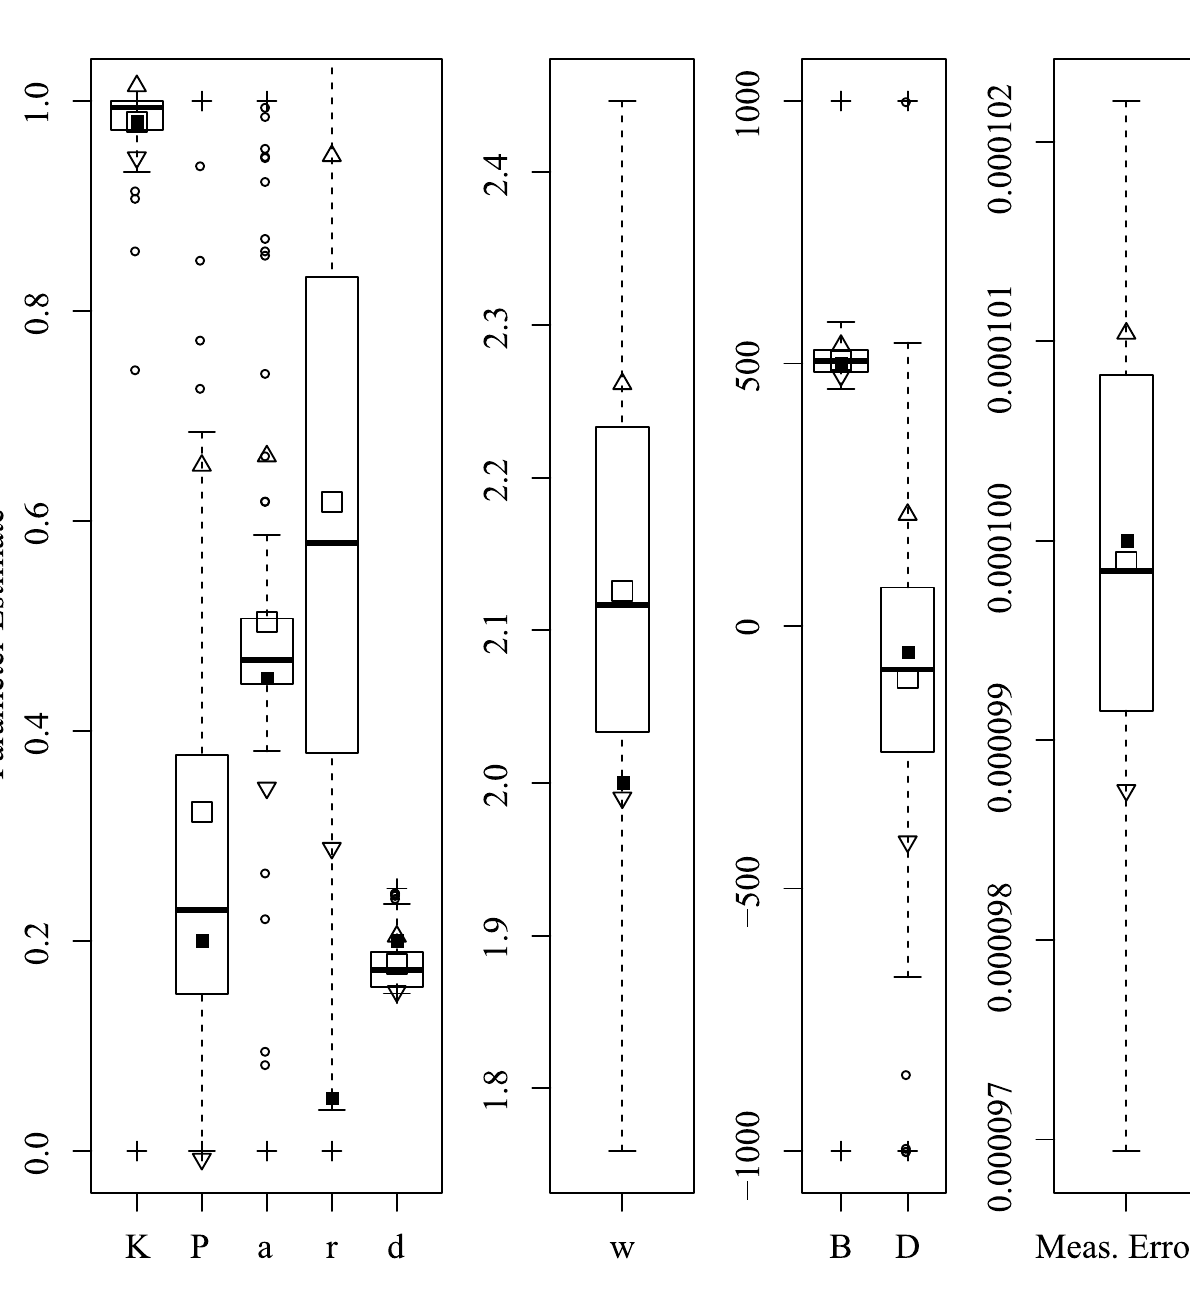
Fig 4. Parameter recovery results for the Rambling and Trembling